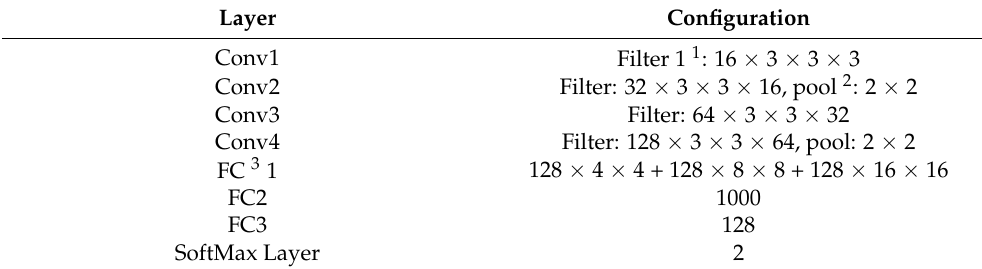
Table 1. Configuration of